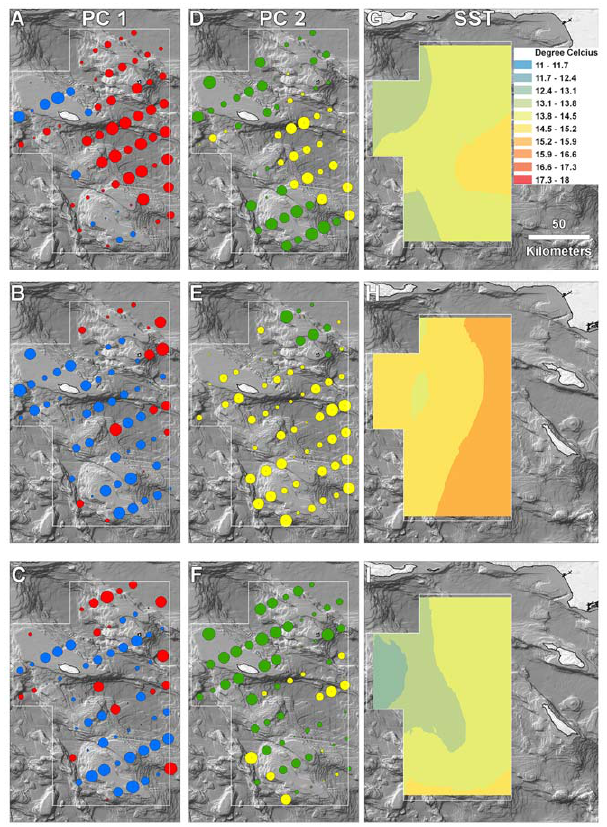
Figure 4. Spatial and temporal variability in assemblage structure and SST at the CCA scale. Principle component 1 (PC1) scores of stations from (A) 2002, (B) 2003 and (C) 2004. Red circles represent positive and blue circles negative loadings on PC1. The size of eachcircle is proportional to PC absolute value. PC2 scores from (D) 2002, (E) 2003 and (F) 2004. Green circles represent positive and yellow circles negative loadings on PC2. See Table 2 for taxa loadings on each axis. Krig-based images of sea surface temperature from (G) 2002, (H) 2003 and (I) 2004.